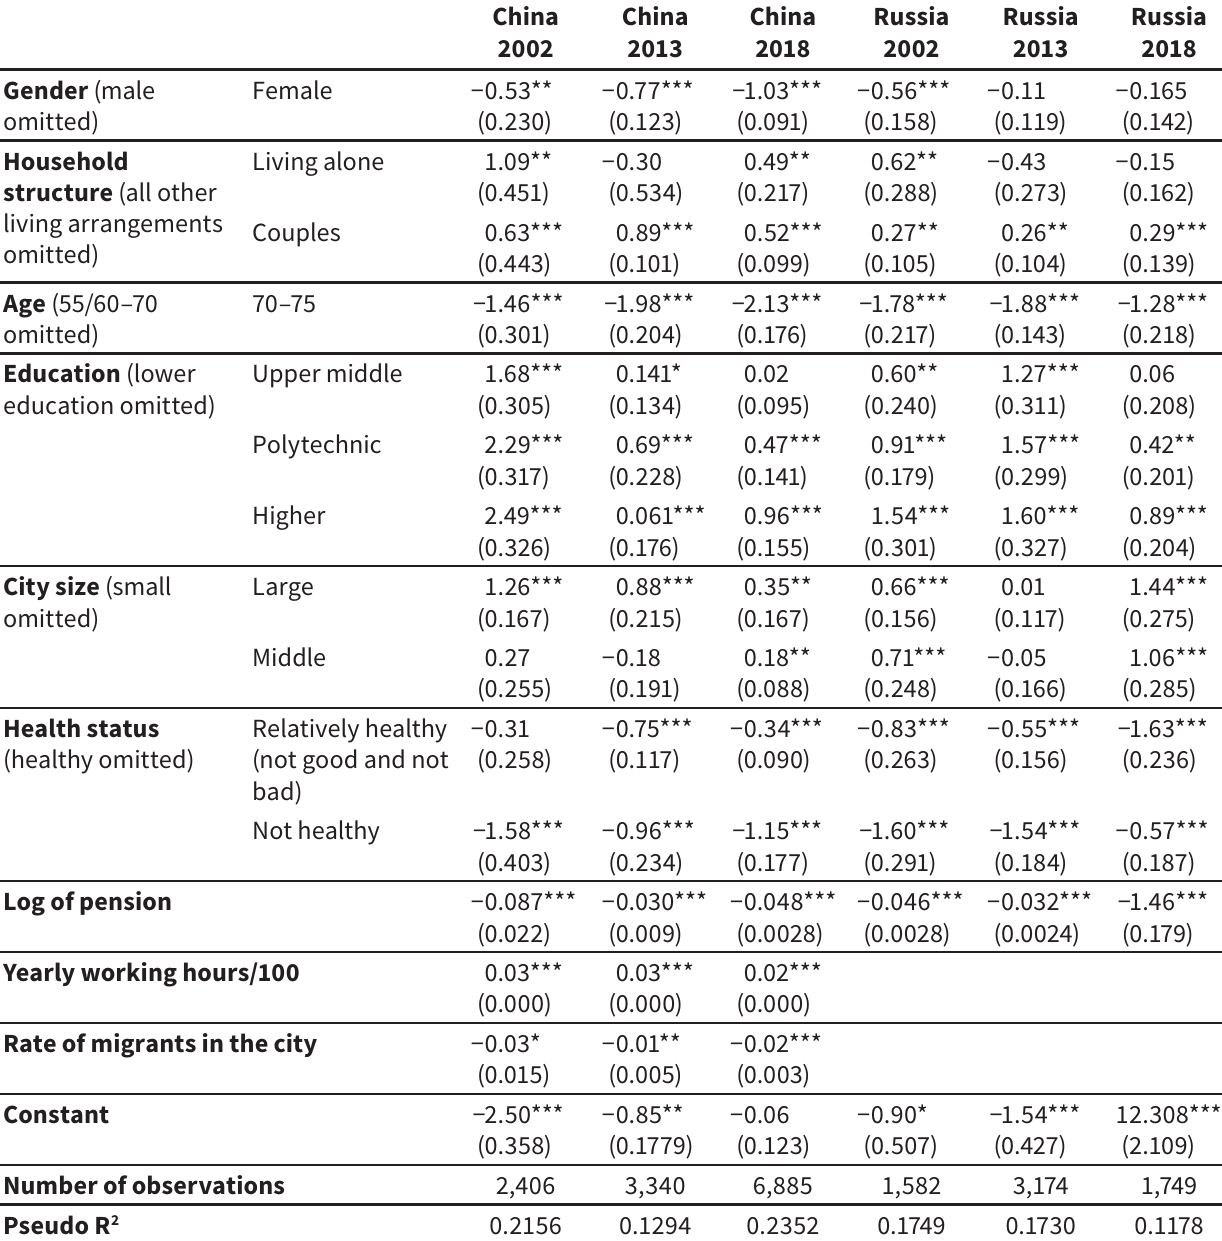
Estimates of employment probabilities for older people in urban China and urban